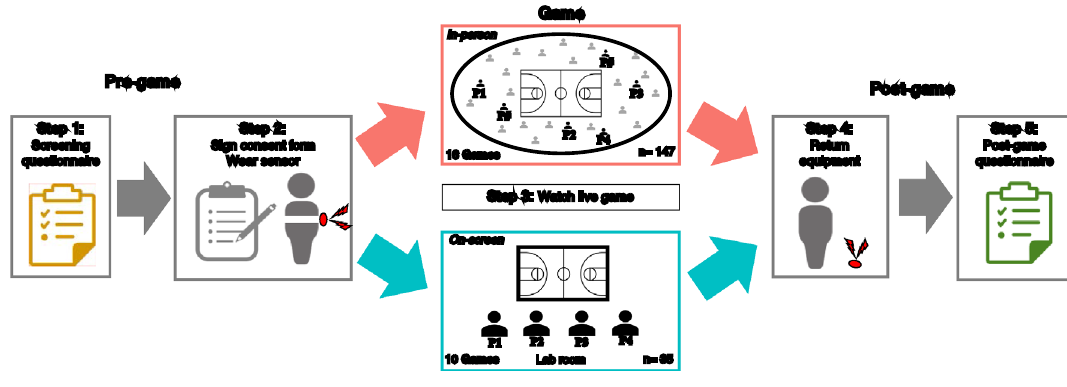
Figure 1. Summary of experimental